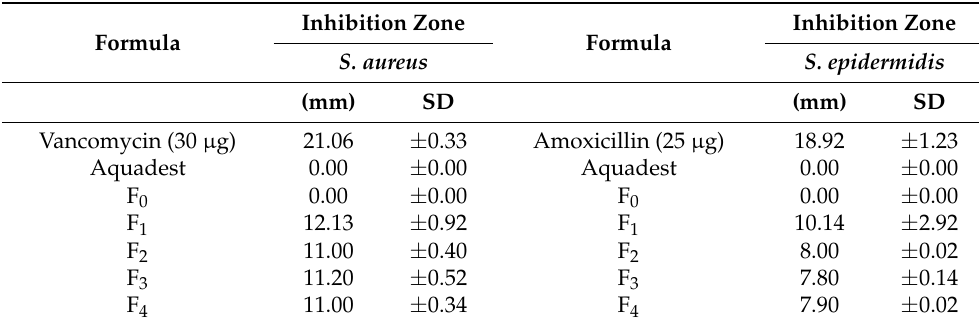
Table 9. Antibacterial activity test of polyvinyl alcohol/corn starch/patchouli oil/hydrogel films loaded with silver nanoparticles.